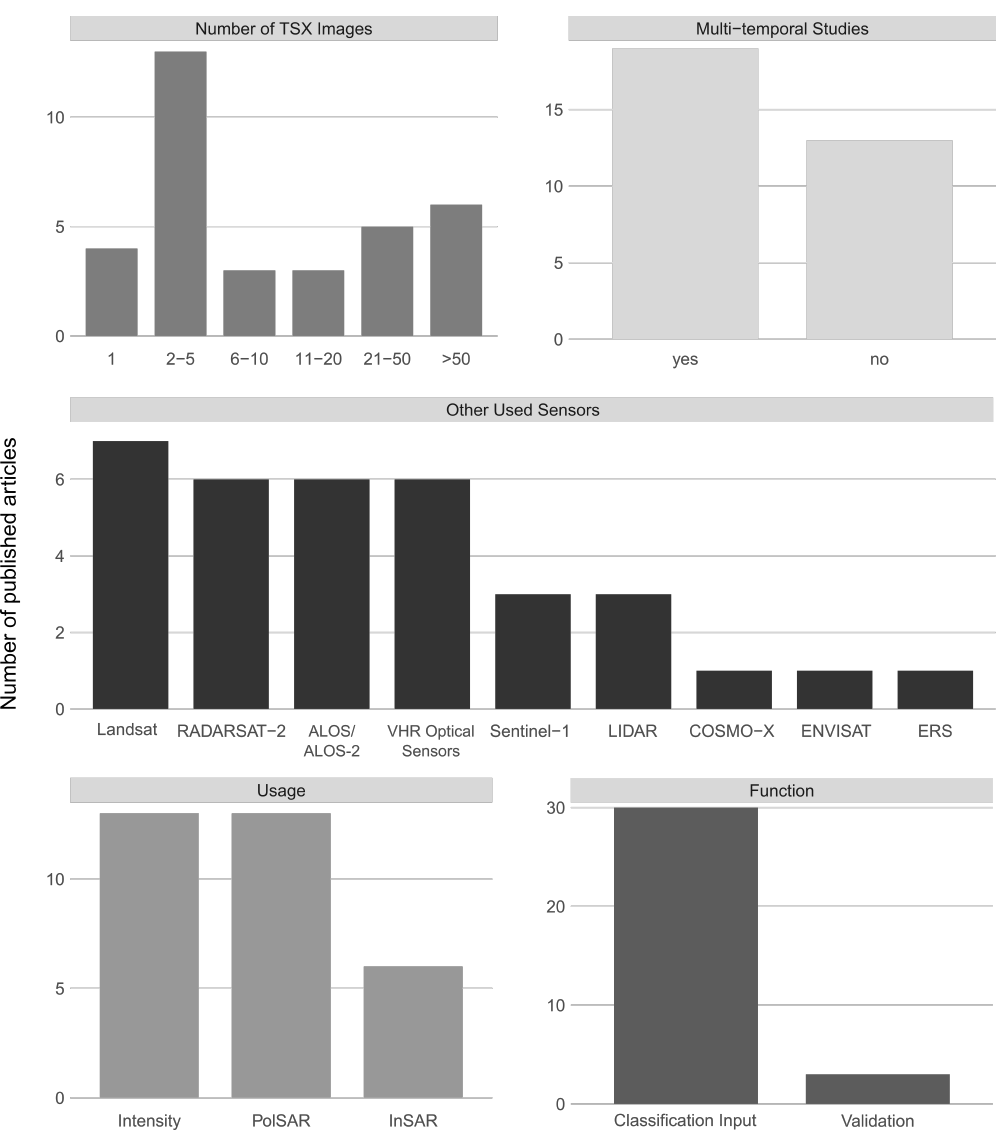
Figure 6. Usage of TerraSAR-X (TSX) data for wetland studies: Amount of images, multi-temporal analysis, other sensors combined, methodological approach, and function of the data. InSAR: interferometric SAR: PolSAR: polarimetric